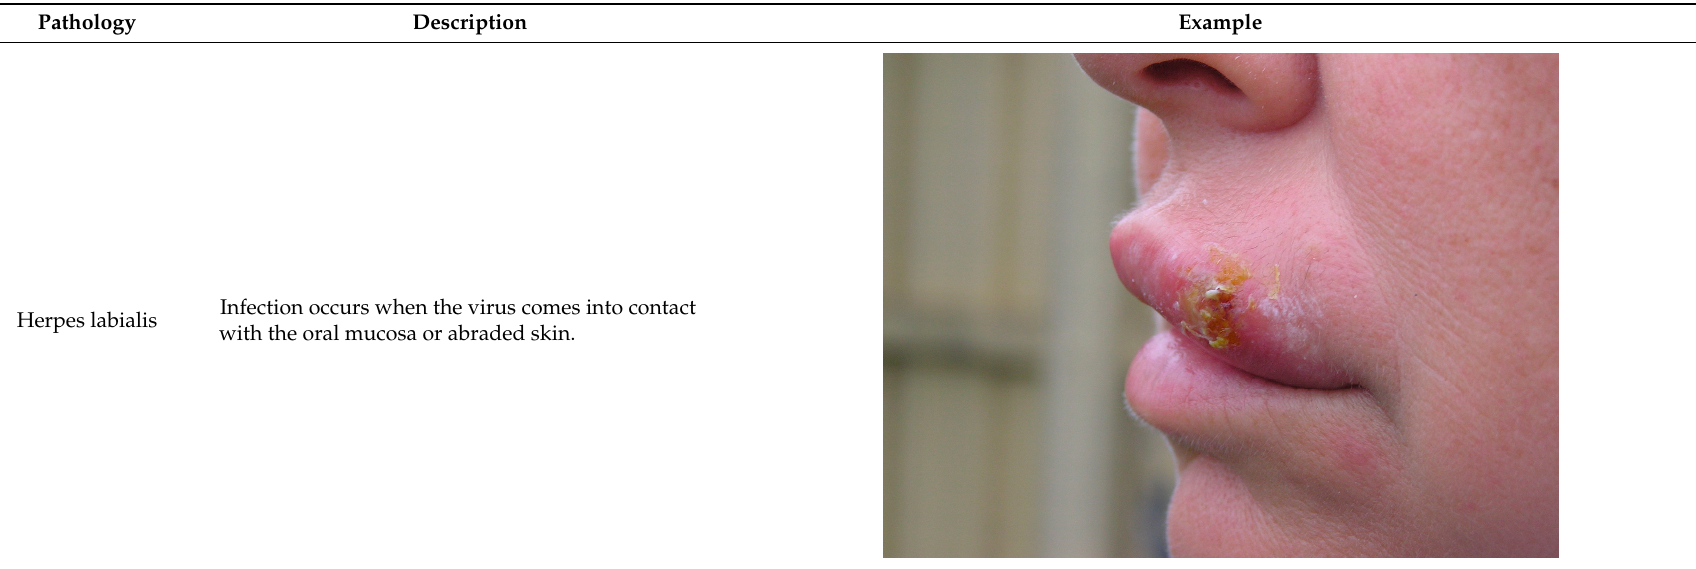
Figure 2. Herpes labialis manifestation, public domain photo, adapted for gentle concession of Ben Tillman